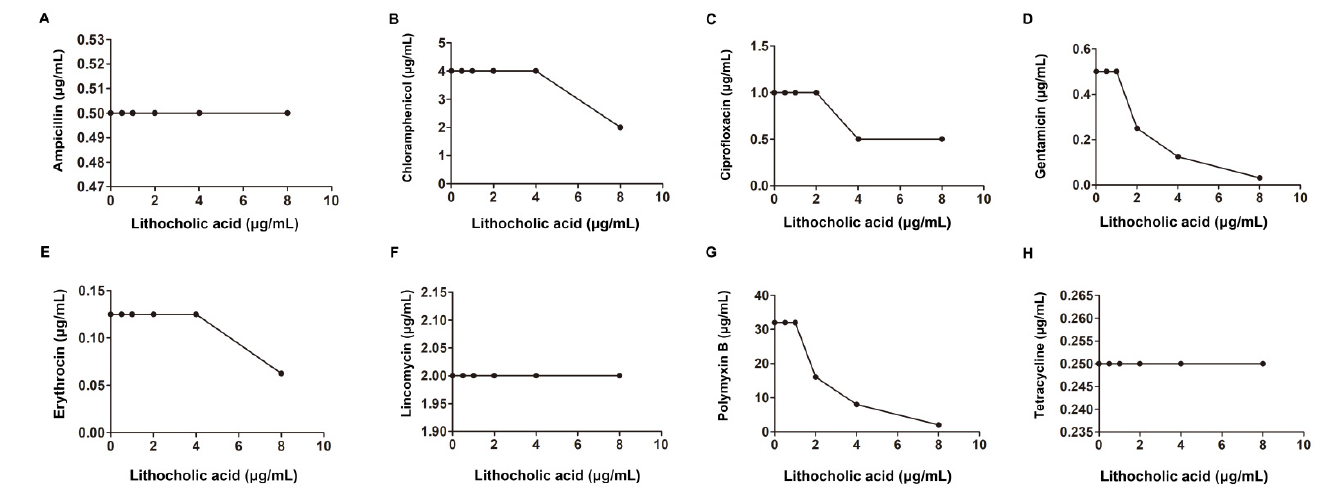
Figure 1. LCA had no influence on the growth of L. monocytogenes at a concentration of less than 16 μ g/mL. ( A ) Chemical structure of LCA. ( B ) Growth curve of L. monocytogenes cultured in TSB con ‐ taining the indicated concentrations of LCA.